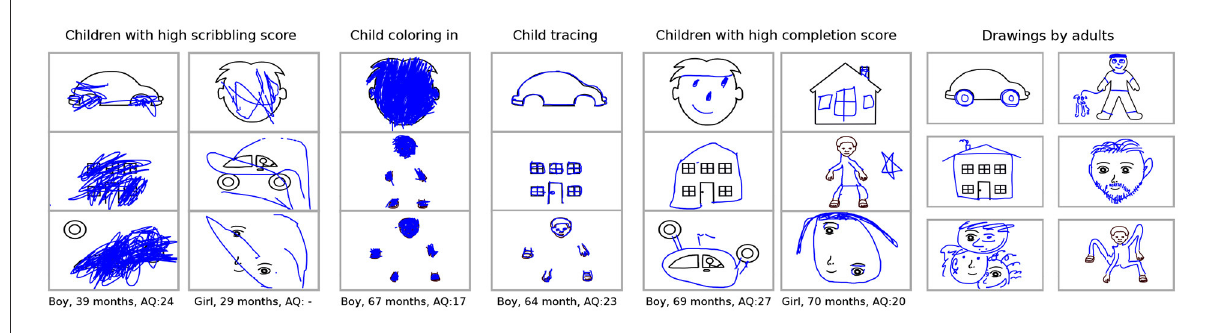
FIGURE4 Examples of drawings of children who received particularly high ratings for different rating categories, and of adult’s